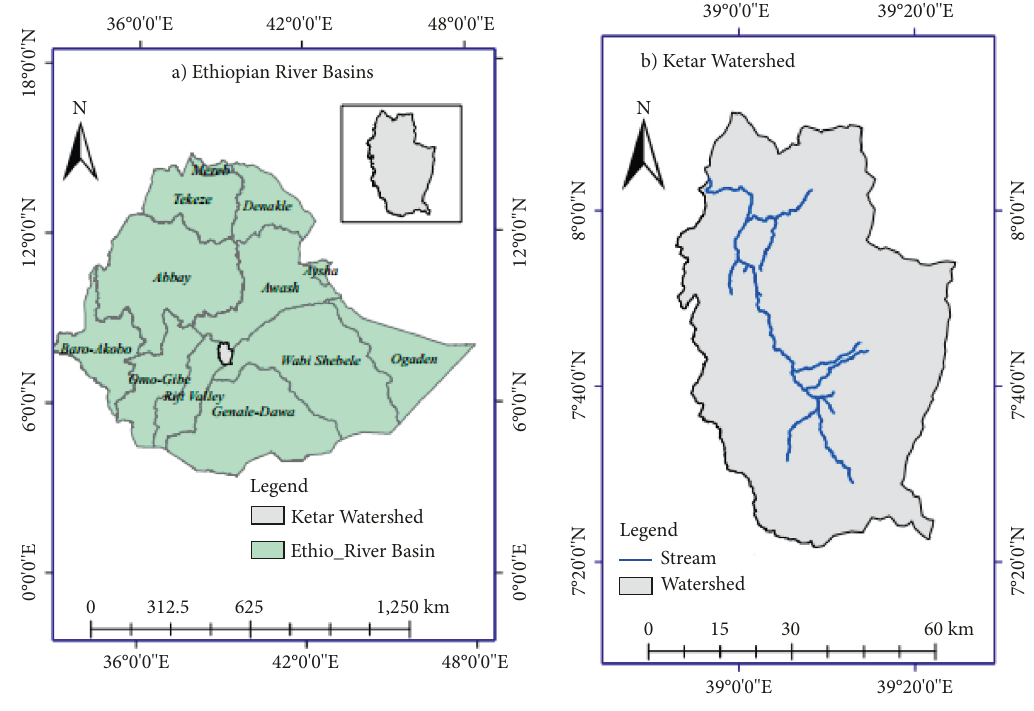
Figure 1: Map of the study area. Table 1: Locations of the meteorological